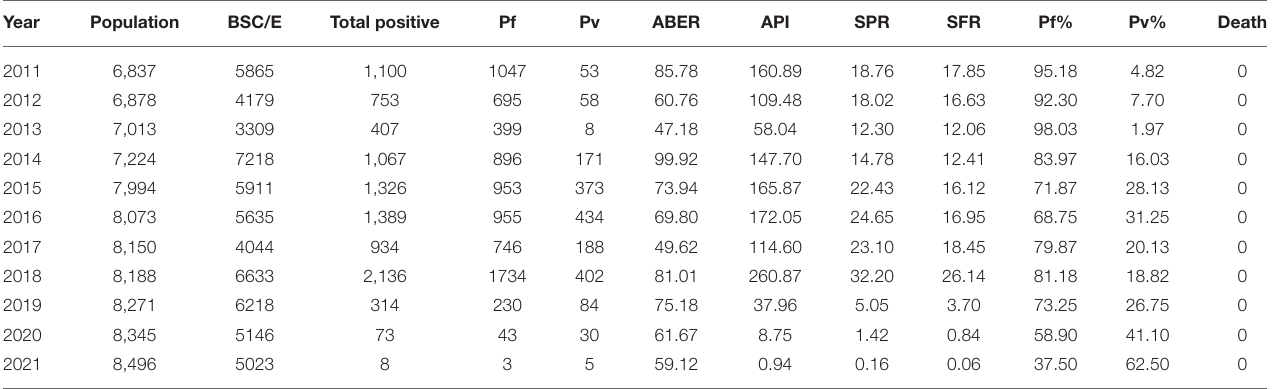
TABLE 1 | Malaria epidemiology in the Dolonibasti